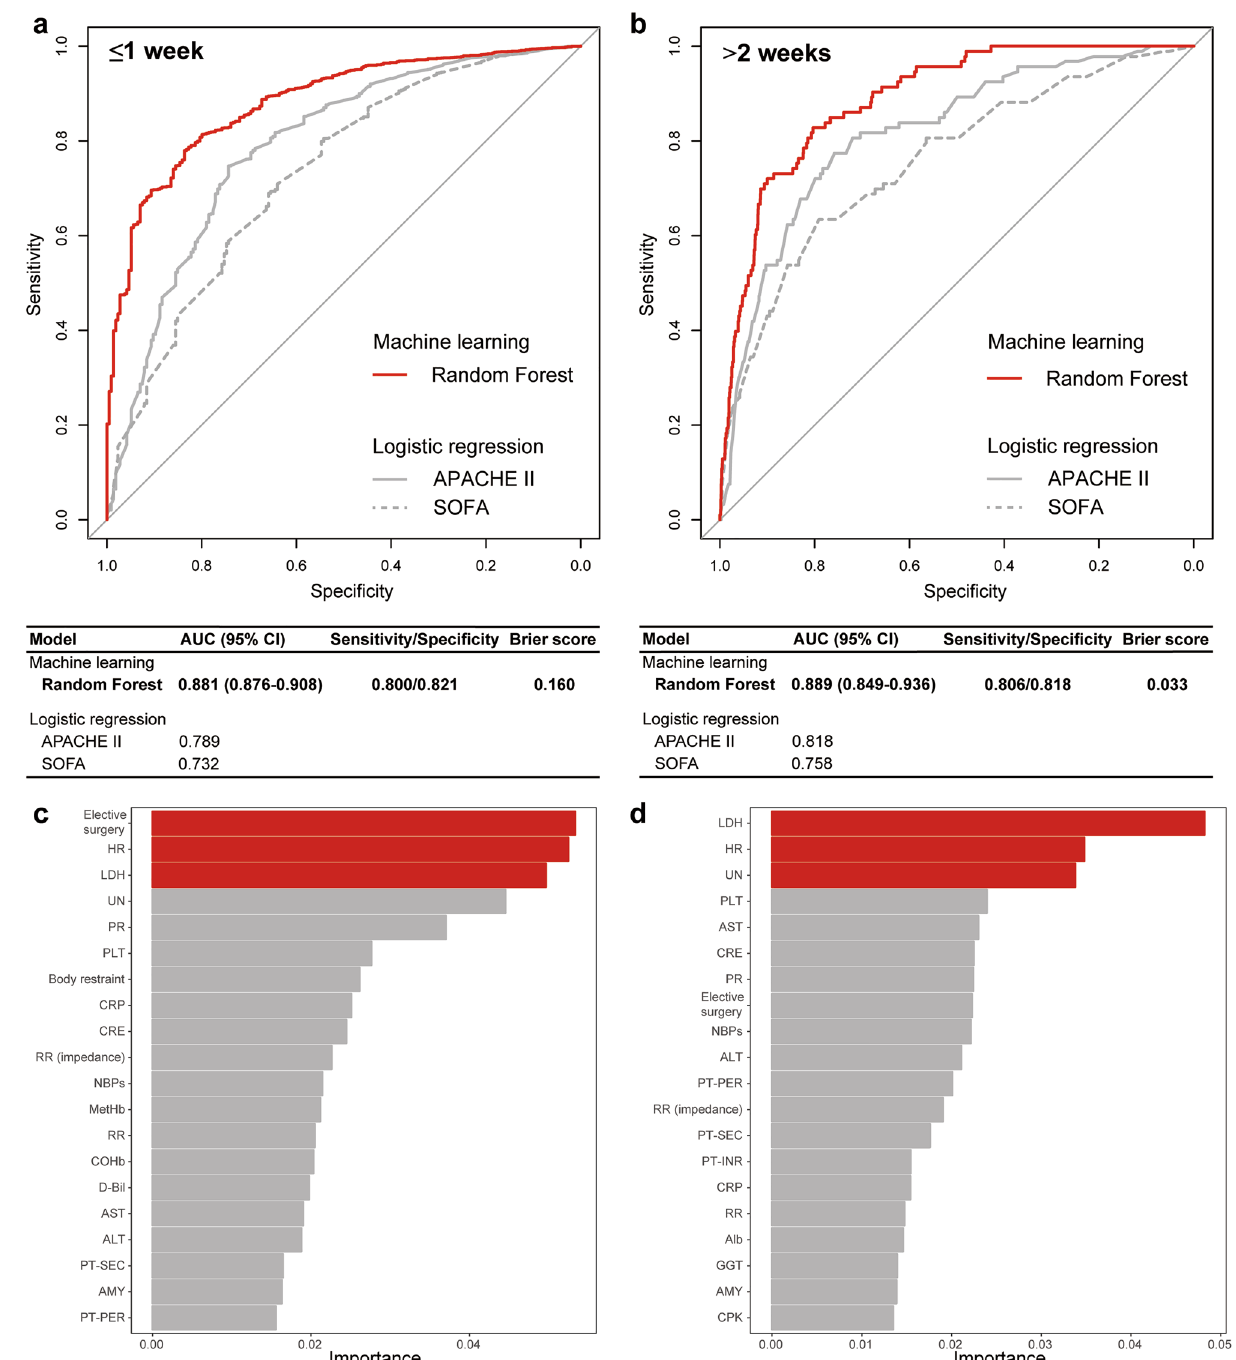
Figure 3. Predictive accuracy and key variables for the length of intensive care unit stay in the test cohort. ( a , b ) ROC curves and AUCs for the short ( a ) and long ( b ) length of ICU stays were derived from the machine learning methods using Random Forest and logistic regression. ( c , d ) Relative importance of variables for the short ( c ) and long ( d ) length of ICU stays in Random Forest. Elective surgery, HR, and LDH had the highest importance for the precise prediction of short length of ICU stay; LDH, HR, and UN had the highest importance for the precise prediction of long length of ICU stay. ROC receiver operating characteristic, AUC area under the curve, CI confidence interval, ICU intensive care unit, APACHE acute physiology and chronic health evaluation, SOFA sequential organ failure assessment, HR heart rate, LDH lactate dehydrogenase, UN urea nitrogen, PR pulse rate, PLT platelet count, CRP C-reactive protein, CRE creatinine, RR (impedance) impedance respiratory rate, NBPs non-invasive systolic blood pressure, MetHb methemoglobin, RR respiratory rate (count), COHb carboxyhemoglobin, D-Bil direct bilirubin, AST aspartate aminotransferase, ALT alanine aminotransferase, PT-SEC prothrombin time (in seconds), AMY amylase, PT-PER prothrombin time (%), PT-INR prothrombin time (international normalized ratio), Alb albumin, GGT gamma-glutamyltransferase, CPK creatine